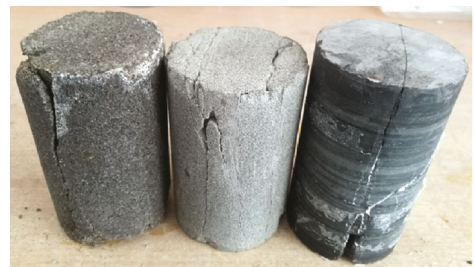
Figure 1: Fractured rock specimens (from left to right: coarse- grained sandrock, fi ne-grained sandrock, and sandy